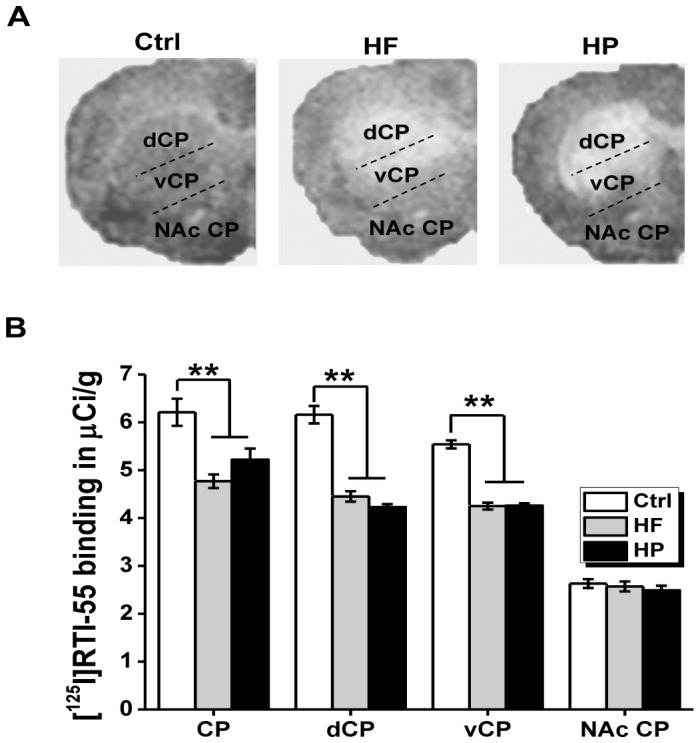
[125I]RTI-55 binding to striatal dopamine transporter (DAT).(A) Representative autoradiographs for each group for DAT binding in the striatum of Wistar rats fed with the control diet (Ctrl), high fatty (HF) or highly palatable (HP) diet. Several regions were observed: caudate-putamen (CP), the dorsal (dCP) and ventral (vCP) subdivisions of the CP, and the nucleus accumben (NAc). (B) Values for DAT binding in the striatum of Wistar rats fed with the control diet (Ctrl), high fatty (HF) or highly palatable (HP) diet (n = 9 for Ctrl group, n = 10 for HF group and n = 11 for HP group). Values were generated by quantitative autoradiography of ligand binding. **p<0.001, compared as indicated.